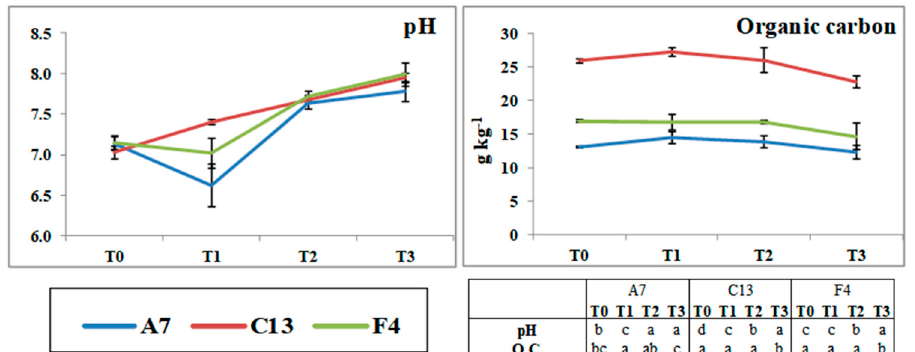
Figure 2. pH and organic carbon (O.C.) content in the three soils at T0 and after each cycle of Brassica juncea (T1, T2, T3). Different letters for each variable in the table indicate significant differences (p < 0.05 ) between the analysis times for each soil. Error bars represent standard deviations.